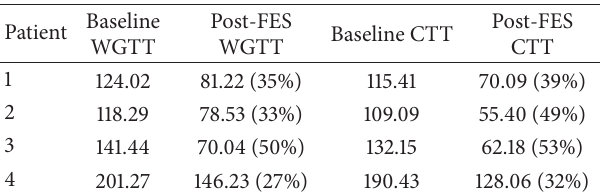
Table 1: Whole gut transit time (WGTT) and the colonic transit time (CTT) in hours before and after six weeks of treatment with functional electrical stimulation (FES) of the abdominal muscles. The percentage reduction of WGTT and CTT after treatment is shown in brackets.